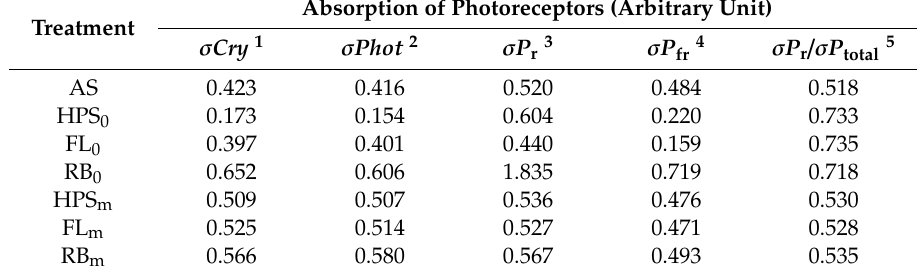
Table 1. Calculated absorptions of plant photoreceptors per 1 µ mol m − 2 s − 1 of photosynthetic photon flux density for the di ff erent spectral treatments (see Section